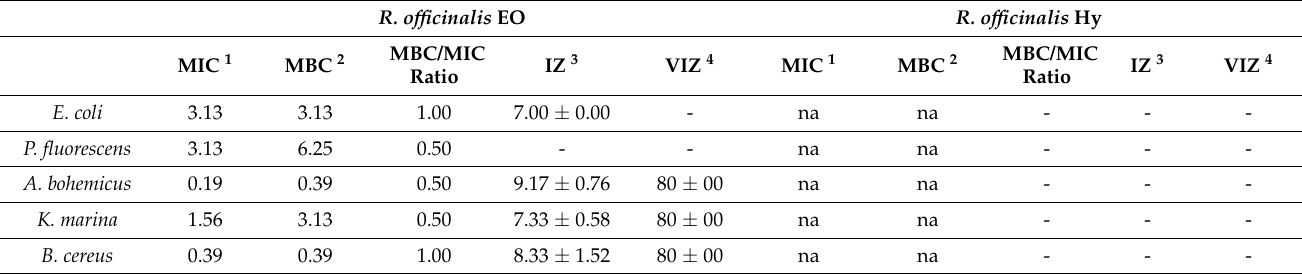
Table 5. Antibacterial activity of Rosmarinus officinalis EO and Hy.